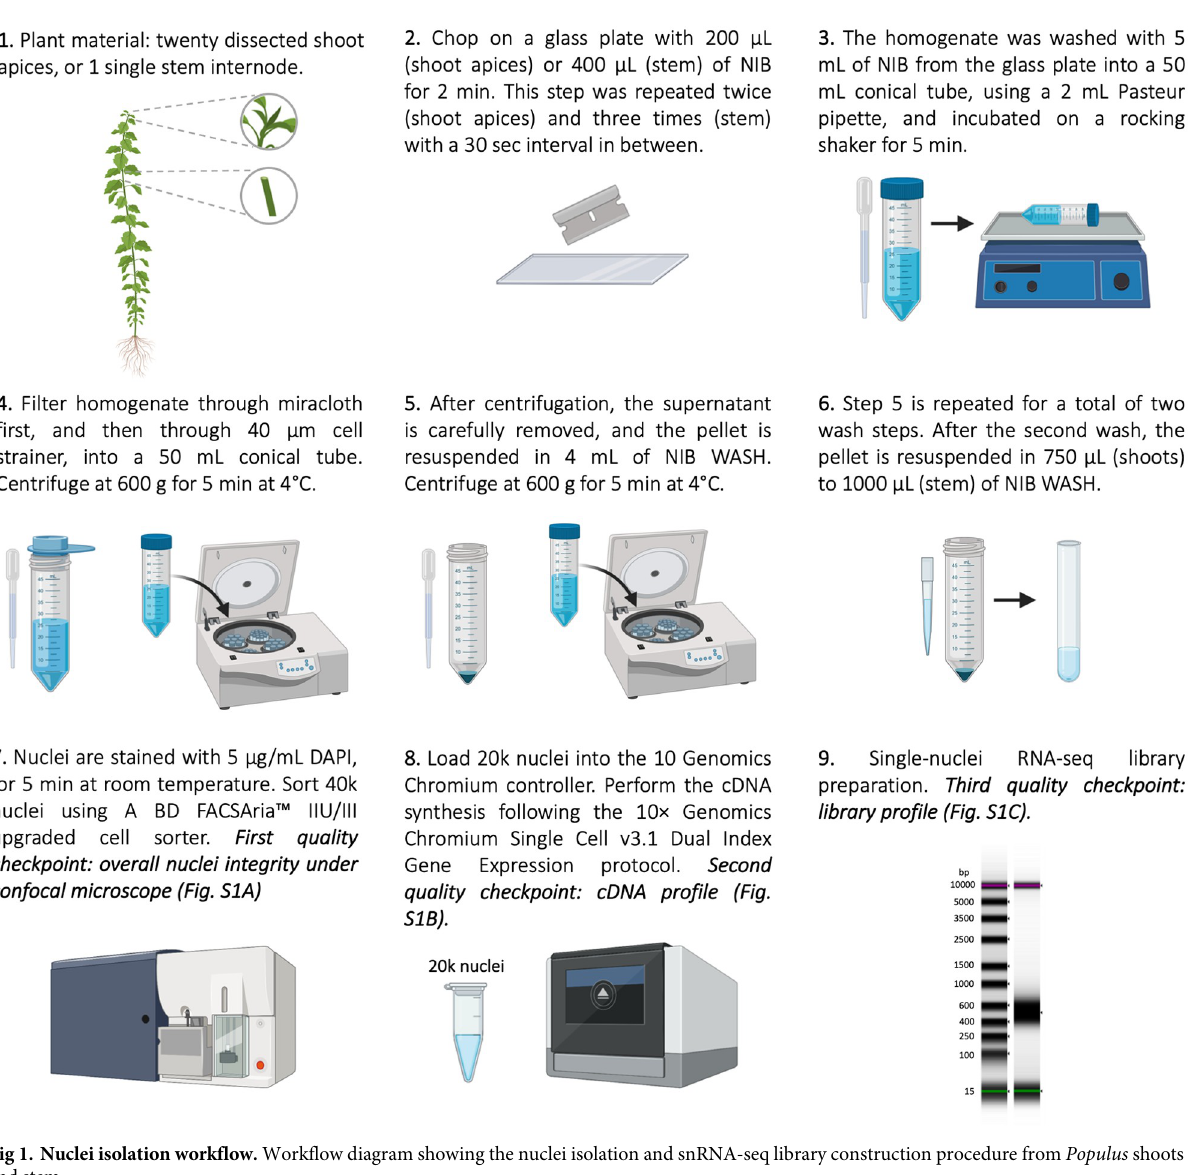
Fig 1. Nuclei isolation workflow. Workflow diagram showing the nuclei isolation and snRNA-seq library construction procedure from Populus shoots and stem.